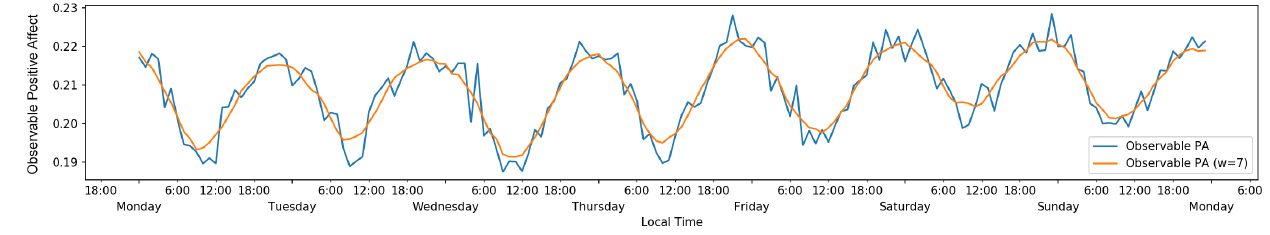
Figure 6. Weekly patterns in local